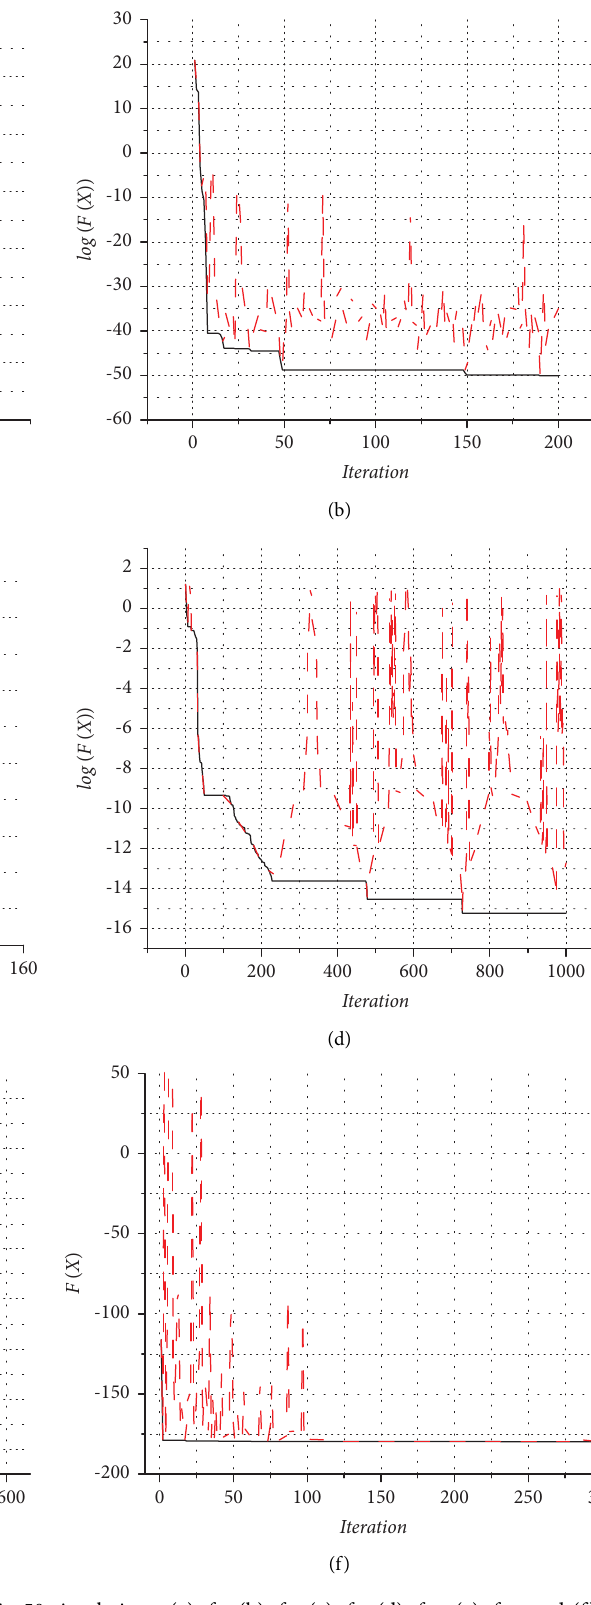
, (b) f , (c) f , (d) f , (e) f , and (f) f 1 2 9 10 21